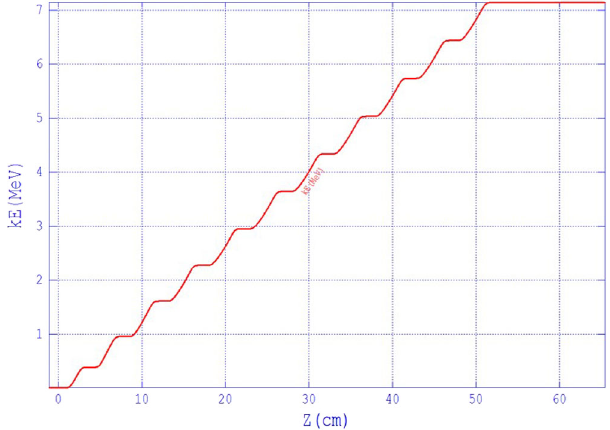
FIG. 7. Linac reflection coefficient Γ .